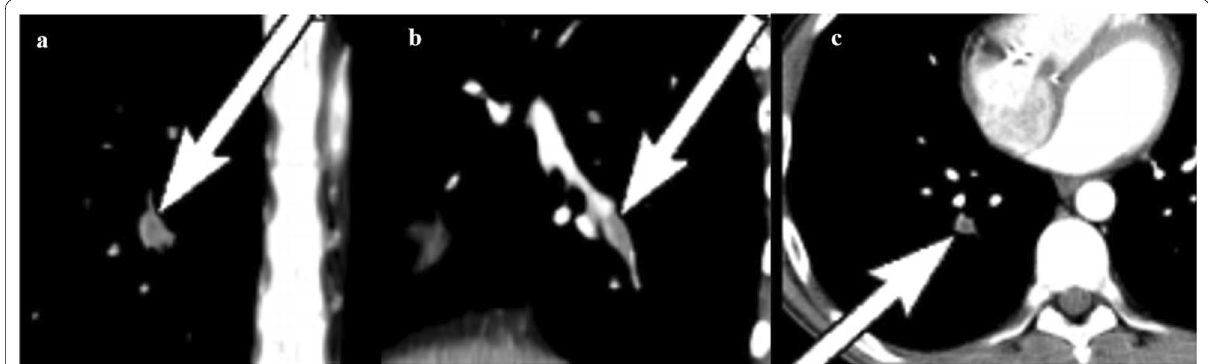
Fig. 2 CT pulmonary angiography revealed filling defects ( arrow ) of pulmonary artery branch supplying right lower lobe, consistent with pulmonary emboli ( a :sagittal plane, b :coronary plane, c :axial